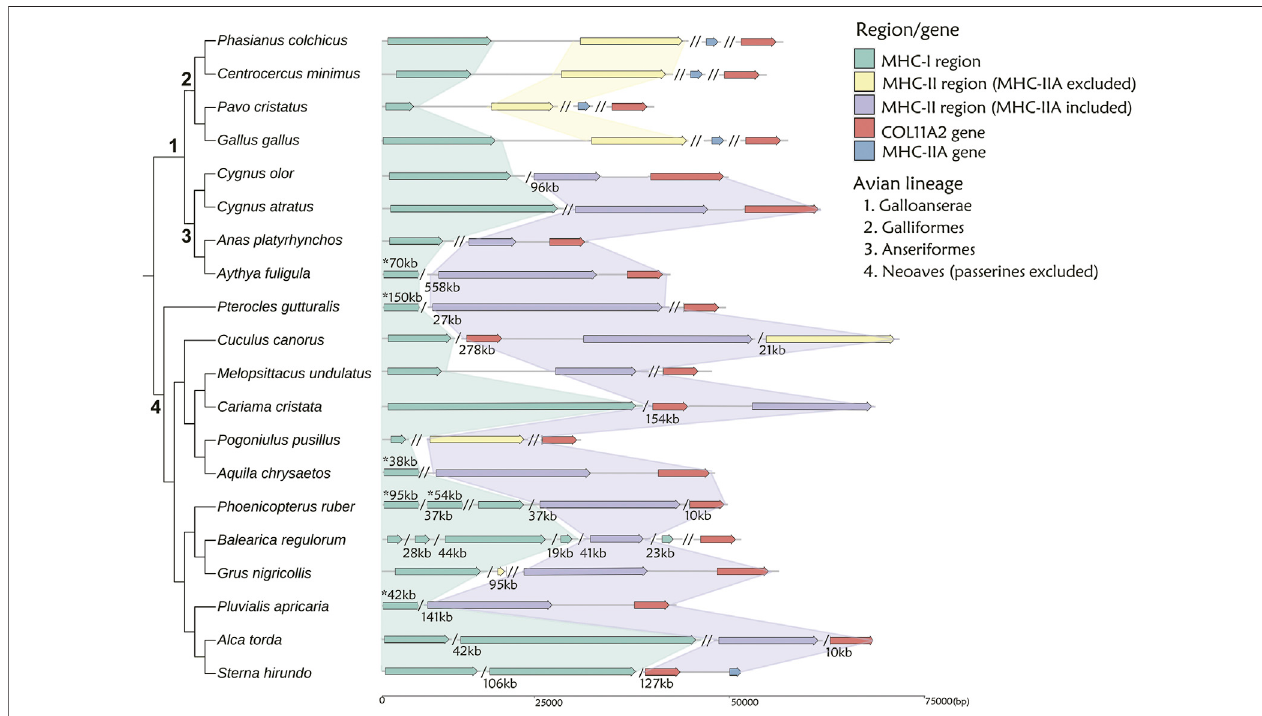
FIGURE3| Thearrangement ofMHC-Iand MHC-IIregionsin20non-passerinebirdspecies.TheMHC-I-related regionismarkedwithgreen,whileMHC-IIregion including or excluding MHC-IIA gene is marked with purple and yellow, respectively. MHC-IIA is marked with blue, when not linked to the core MHC-II region. A single slash indicates the same contig or chromosome (numbers listed under the gene arrangement patterns indicate the total length of missing distances associated with single slashes), while a double slash indicates different contig or chromosome. The numbers marked with asterisks (above gene arrangement) indicate the distances that do not match the scale. Note: 1 Visualization of MHC structure for Anas platyrhynchos based on genome-2 in Table 1 (GCA_900411745.1), while the distance between MHC-I and MHC-II regions was 310 kb in genome-1 (GCA_015476345.1).